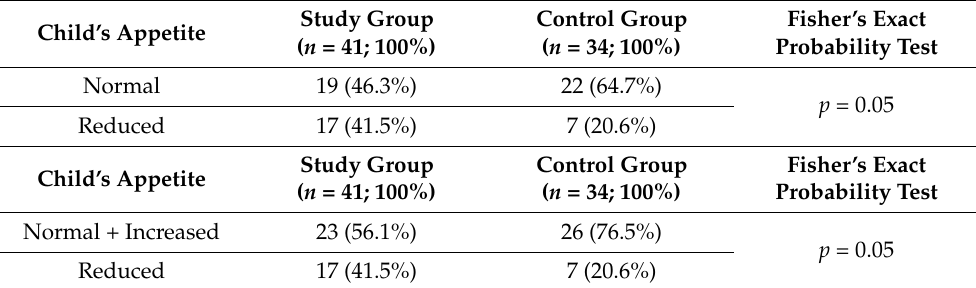
Table 3. Distribution of appetite of children in the Study Group and the Control Group (question II/6).